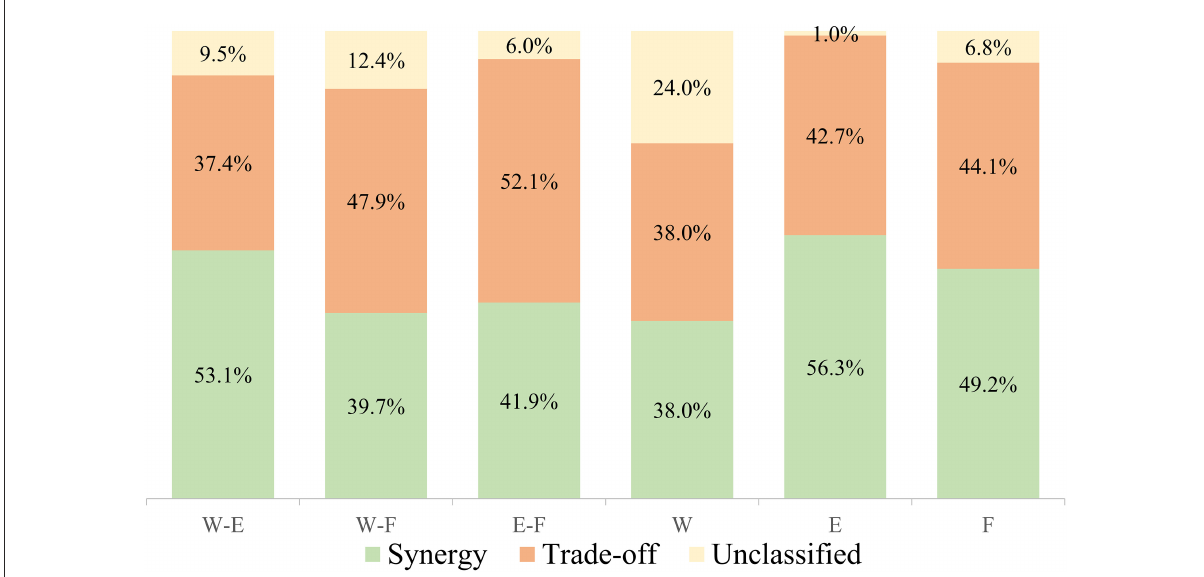
FIGURE3 Interactions between WEF security indicators in South Korea indicated by the proportions of synergies, trade-offs, and unclassified items based on Figures 1, 2.